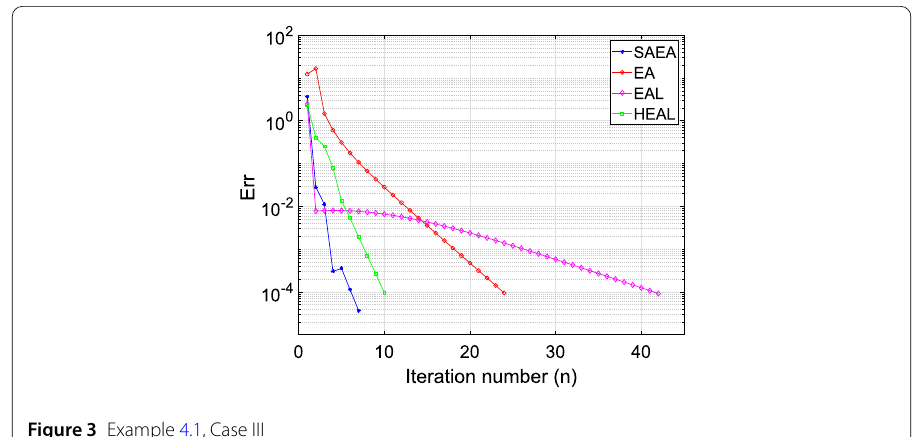
Figure 3 Example 4.1, Case